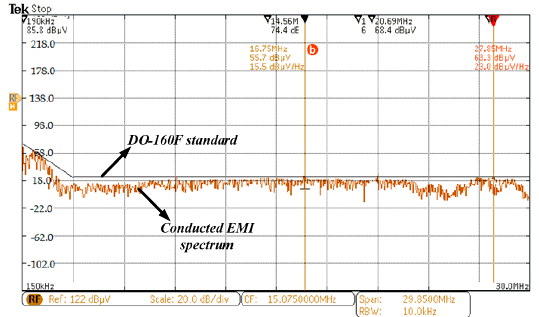
Figure 9. Hardware EMI Spectrum satisfying the DO-160F EMI Standard.